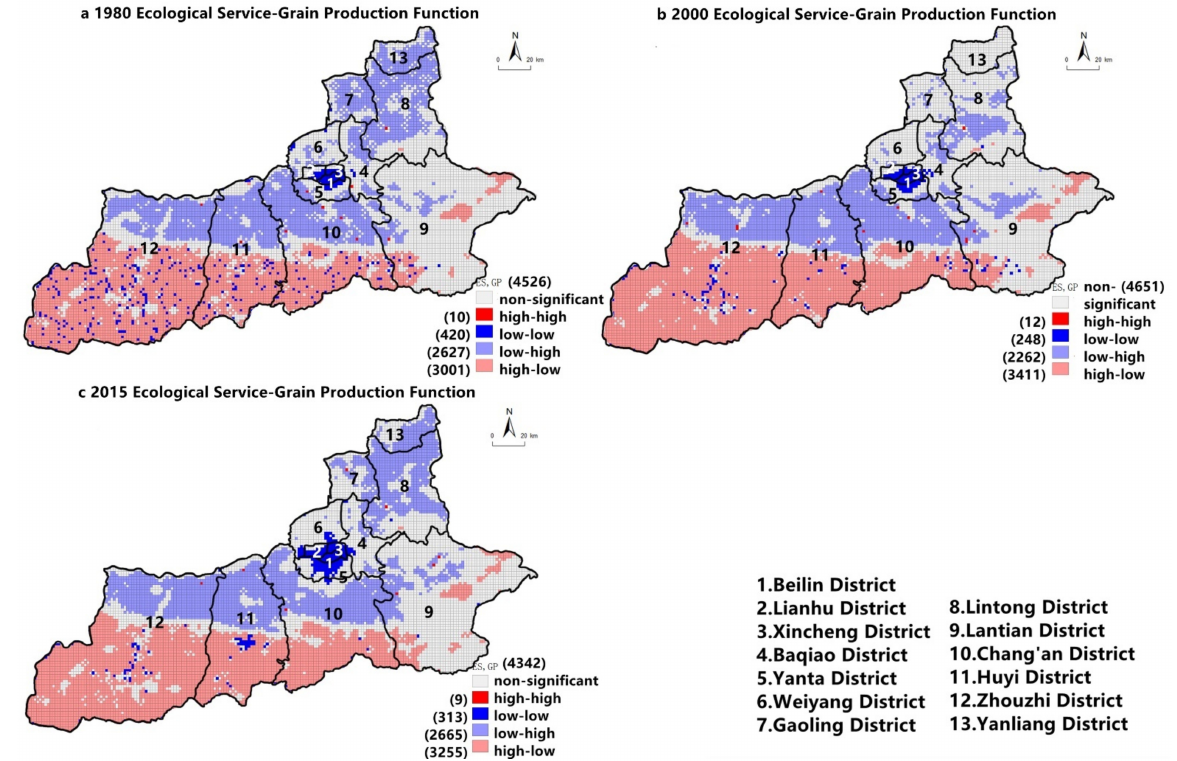
Figure 7. LISA Map of land system Ecological Service—Grain Production Function in Xi’an city from 1980 to